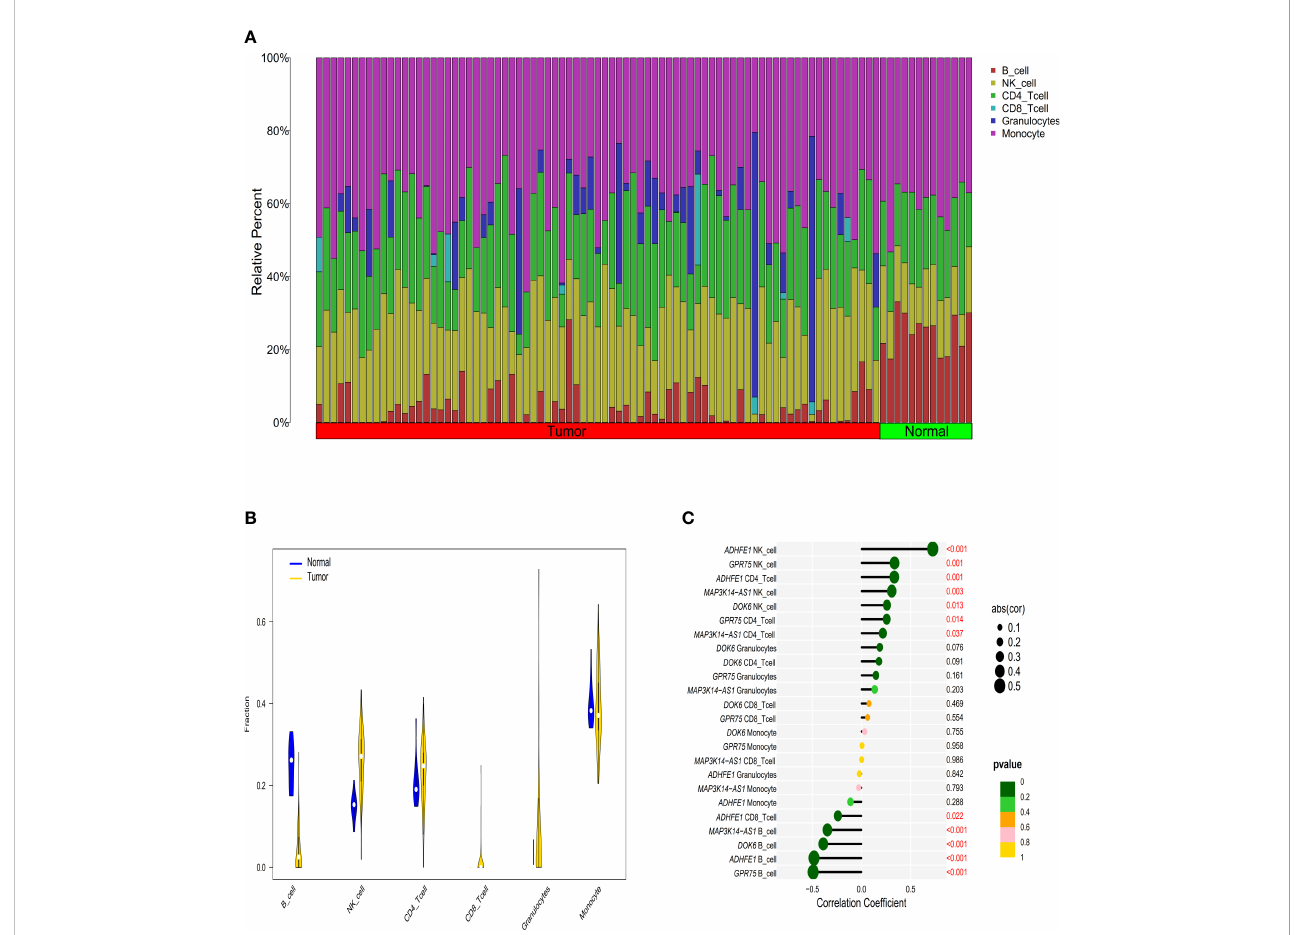
FIGURE 3 The relationship between immune cell in fi ltration characteristics and diagnostic biomarkers in CRC patients with high TMB. (A) The composition of tumor immune in fi ltrating cells in every high TMB sample. (B) Violin diagram of the difference in in fi ltration between the two groups of samples. (C) Correlation between diagnostic markers and immune in fi ltrating cells with the size of the dots representing the strength of the correlation between genes and immune cells and the color of the dots indicating the P